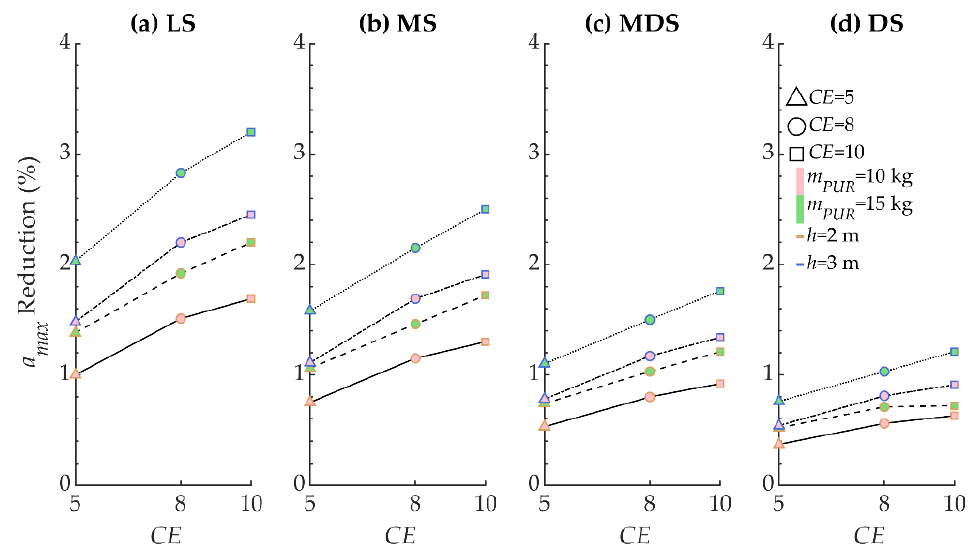
Figure 12. Summary of the acceleration reductions.